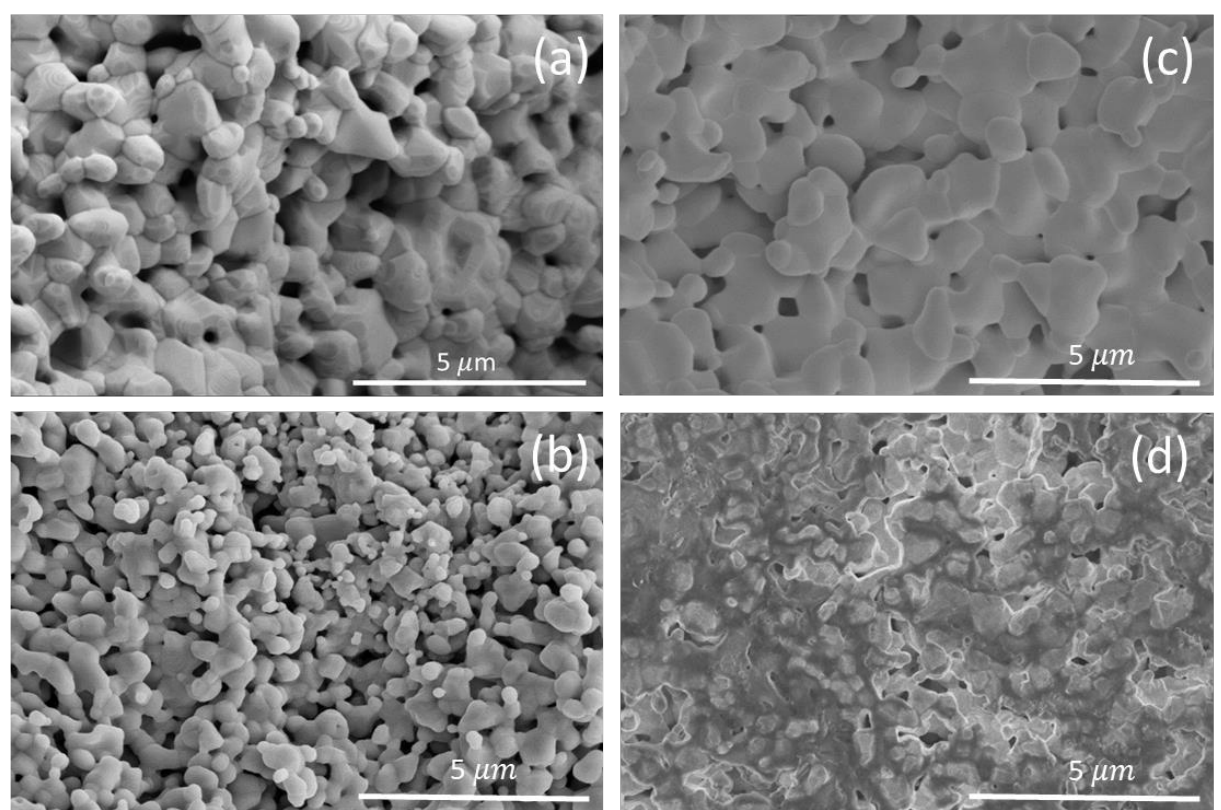
Figure 5. SEM micrographs of cross-section fractures of the specimens obtained using a maximum current density of 50 mA mm −2 at ( a ) 1173 K (optimized conditions), ( b ) 1073 K, ( c ) 1273 K. ( d ) Mi- crograph that shows the effect of current localization (56 mA mm −2 at 1173 K).